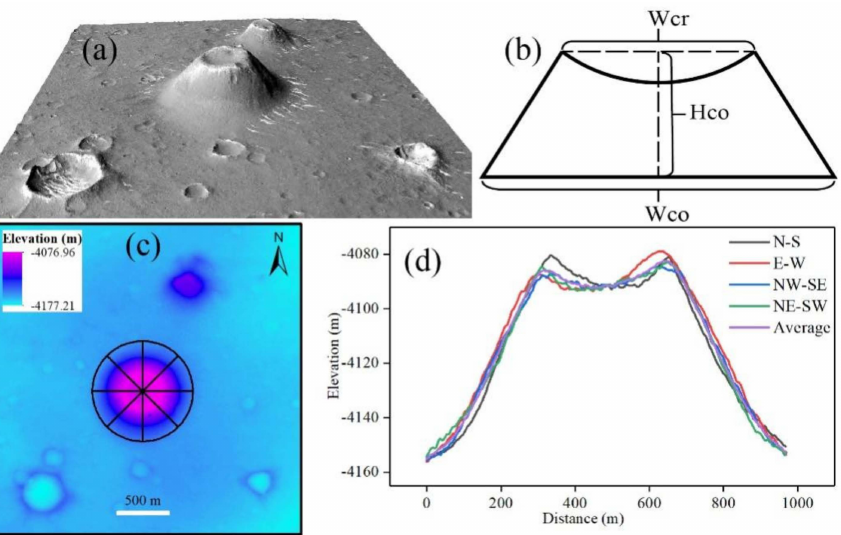
Figure 2. ( a ) Example of 3D reconstruction result of the landing area cones. ( b ) Schematic diagram of the morphometric parameters of a cone. How we acquired the cone topographic profiles from HiRIC − derived DEM is shown in ( c ), and ( d ) is an example of calculating average profile of a cone based on topographic profiles in four